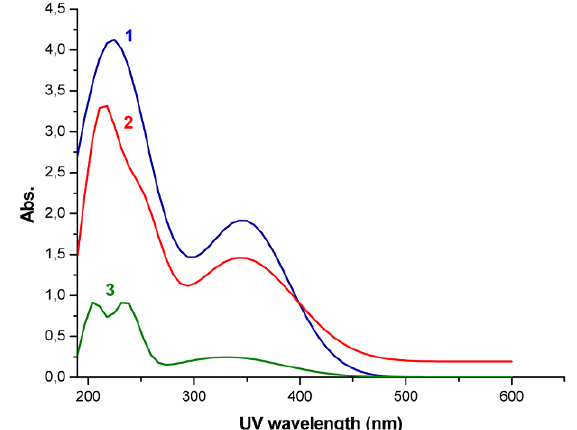
Figure 3. UV-VIS spectra corresponding to micellar systems Sample 6: with nifedipine (1), without nifedipine (2). Nifedipine spectrum in ethanol Table 2. Micelles’ disaggregation under UV irradiation.